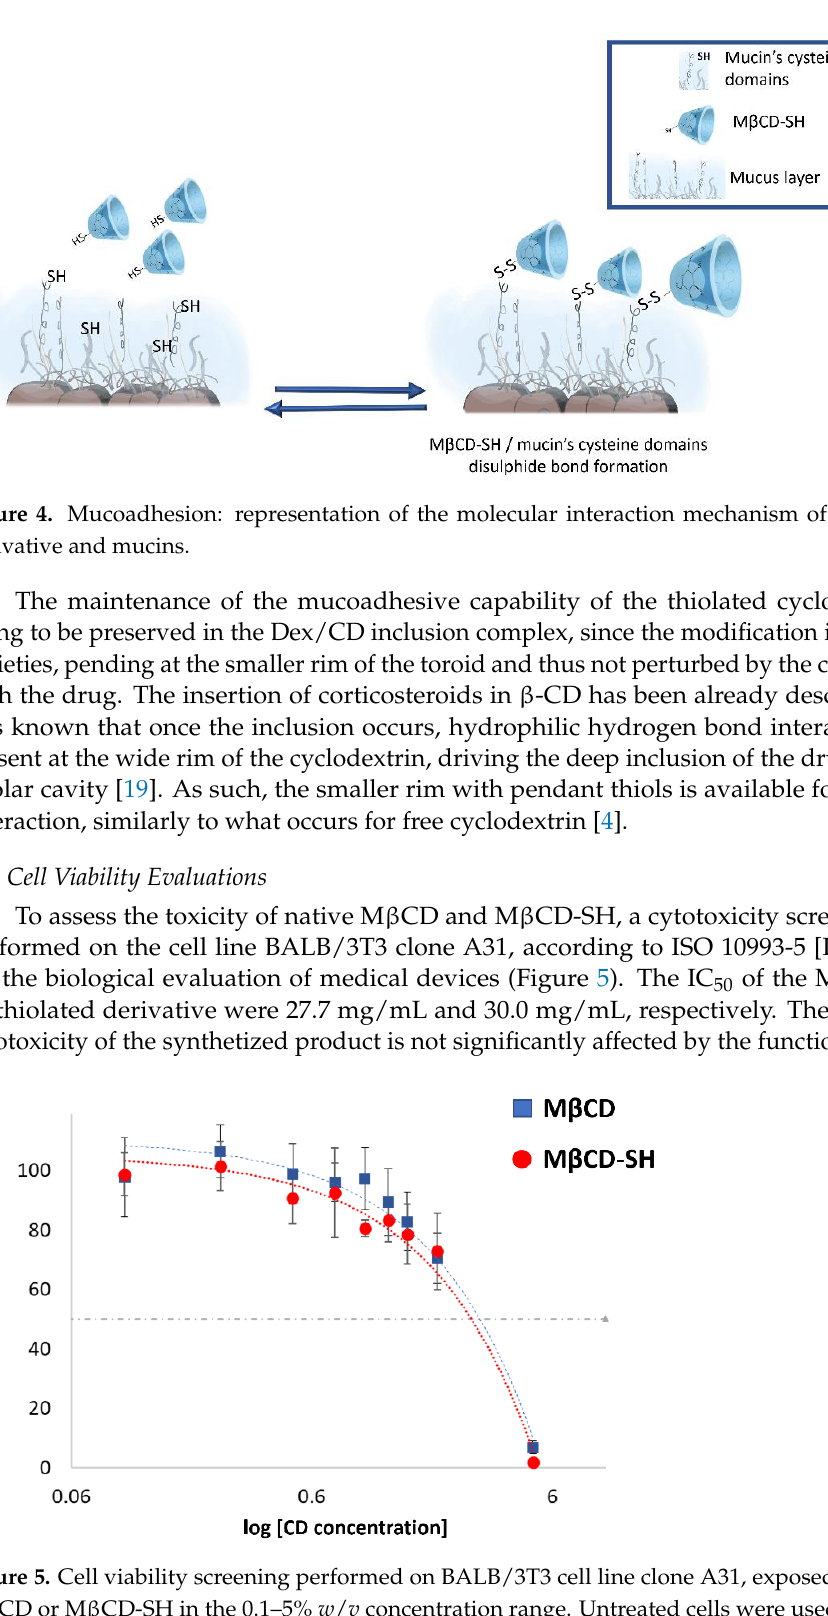
Figure 5. Cell viability screening performed on BALB/3T3 cell line clone A31, exposed for 24 h to MβCD or MβCD -SH in the 0.1 – 5% w / v concentration range. Untreated cells were used as